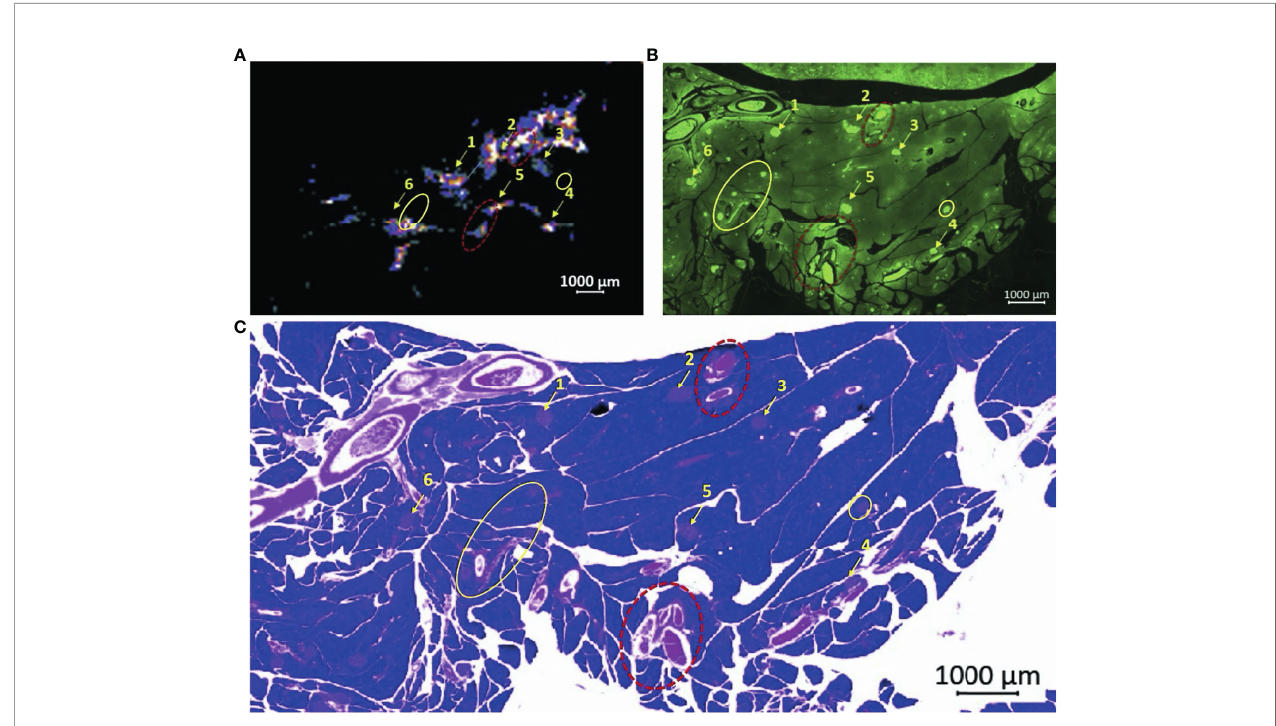
FIGURE 2 | Co-registration experiment demonstrating the correlation of ex vivo MRI “ hot spots ” with islets as detected by immunohistochemical staining for insulin. (A) MR signals detected in an ex vivo pancreas removed from a rat 5 min after injection of GdL 2 plus glucose. Setting the color scale to “ cool ” allows visualization of individual hot spots as indicated by the numbered arrows. (B) Islets identi fi ed by immuno fl uorescence staining for insulin, matched to the MR imaging plane shown in (A) demonstrates a majority of visualized “ hot spots ” in the MR images correspond to islets. (C) H&E staining also identi fi es islets and blood vessels. Note that some hot spots observed by MRI actually re fl ect blood vessels (red dotted circles), respectively. Interestingly, some insulin-stained islets do not appear as hot spots in the MR image shown in (A) (yellow